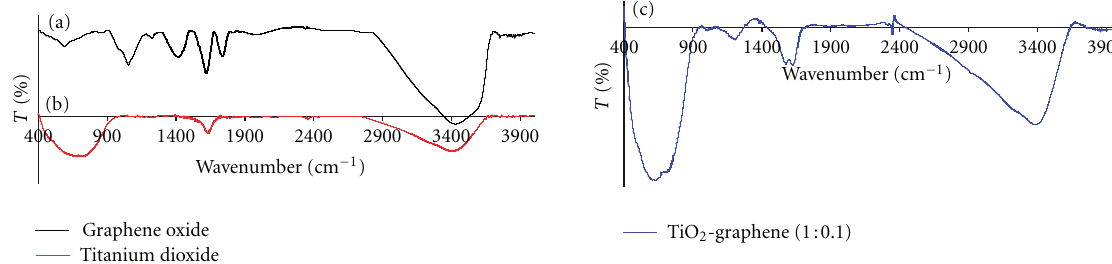
F 3: FTIR spectra of (a) acid-functionalized graphene oxide, (b) titanium dioxide, and (c) TiO